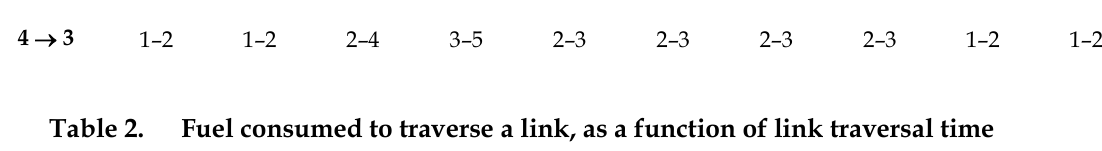
Fuel consumed to traverse a link, as a function of link traversal time Link